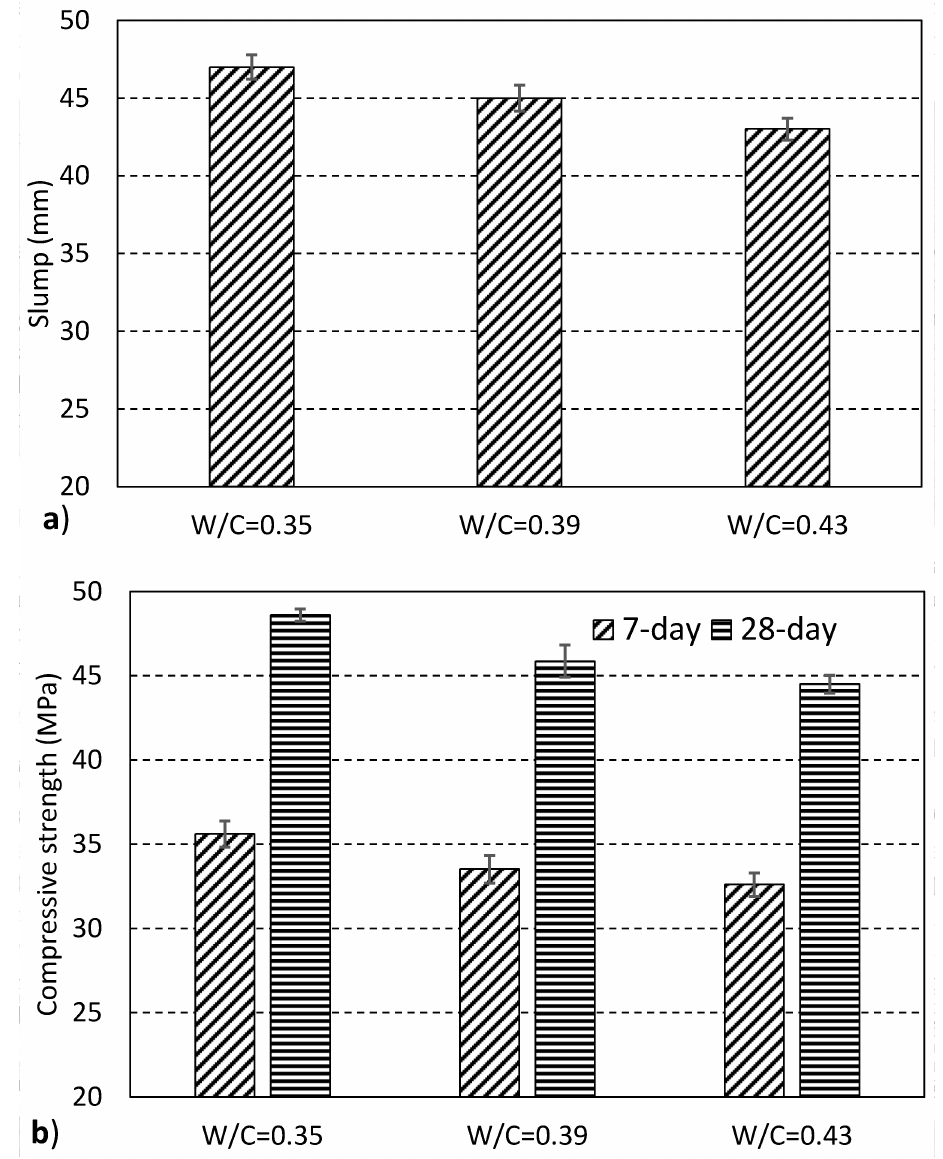
Figure 8. The properties of the concrete at various W/C ratios: ( a ) slump of fresh concrete; and ( b ) 7-day and 28-day compressive strength of hardened